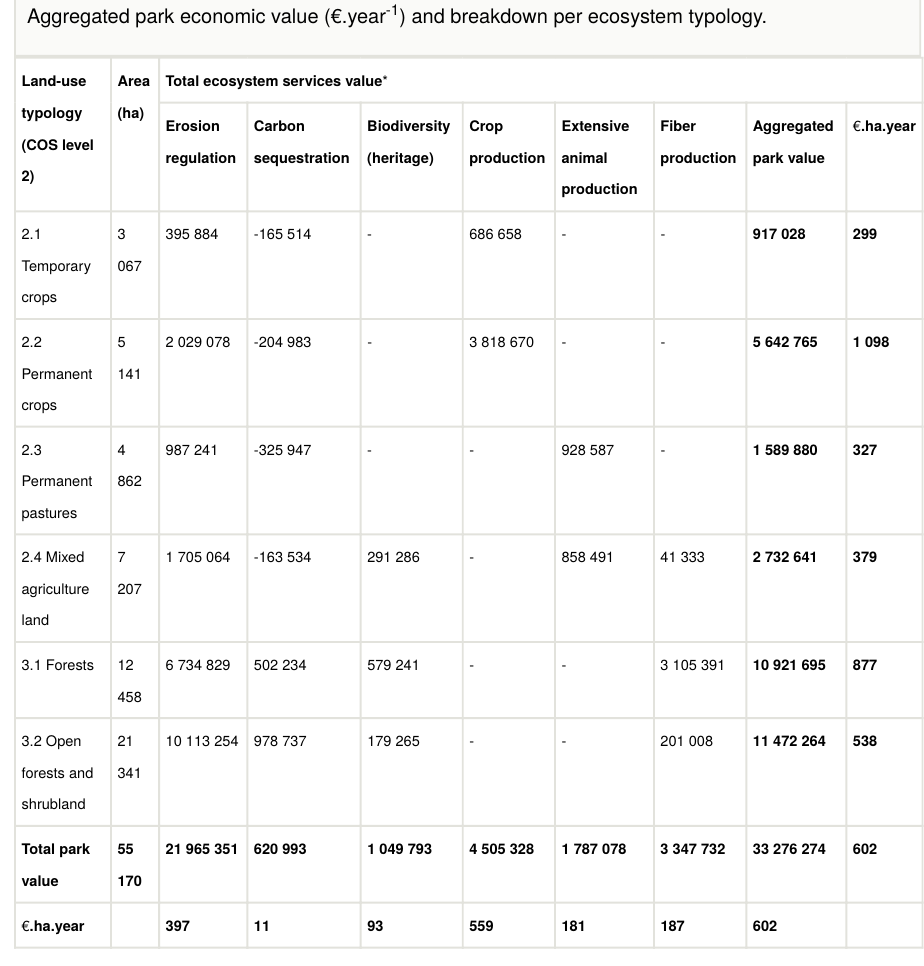
LULC cartography (COS 2007 level 2). Based on our fi ndings (Table 4), forests and shrubland are the ecosystems contributing most to the park’s annual economic value. Given the greater expression of forests and shrubland ecosystems within PNSSM in terms of area (Table 4), we performed a per hectare analysis to compare the value of services delivered by di ff erent ecosystems (Fig. 13). Results show that permanent crops deliver higher value of provisioning services (750 €.ha .year ), whereas forests and shrubland ecosystem deliver higher value of regulating and cultural services (over 500 €.ha .year ). -1